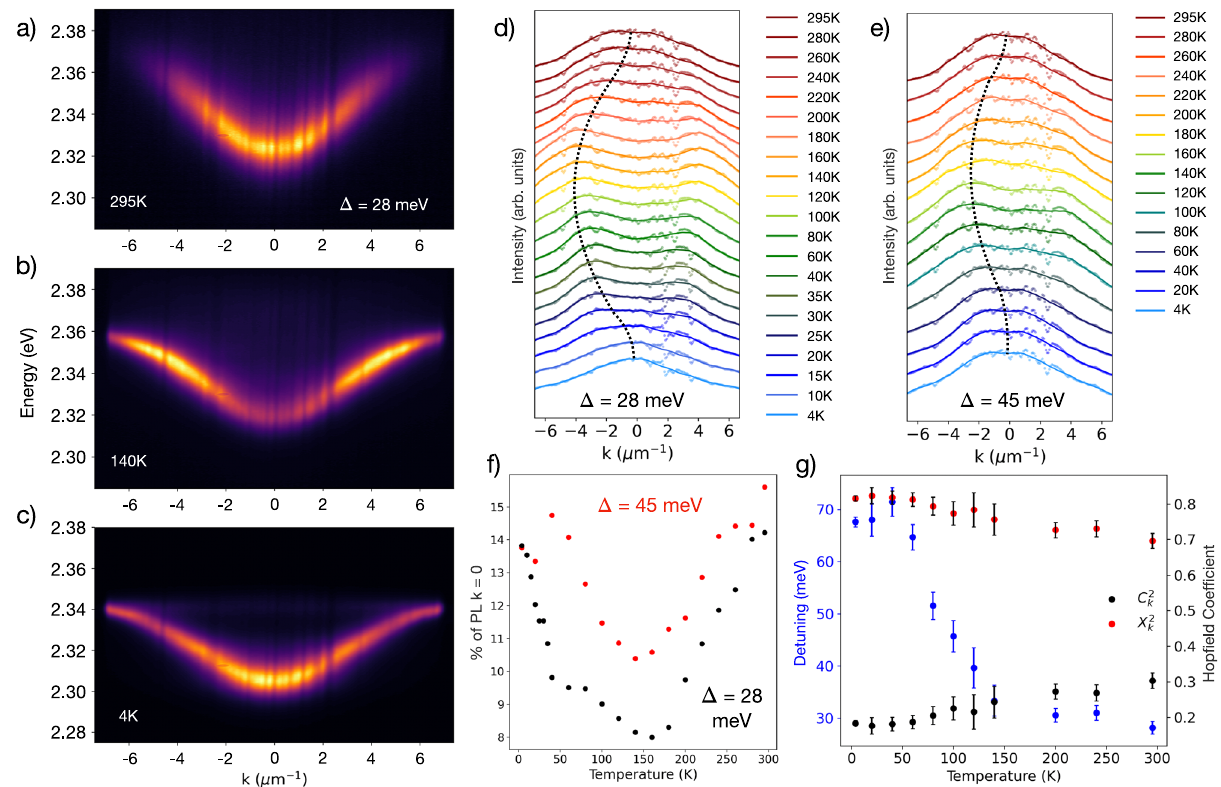
Fig. 2 | Temperature dependence of the exciton-polariton bottleneck effect. a – c Lower polariton branch (LPB) photoluminescence (PL) for Δ =+28meV cavity detuningasafunctionoftemperaturerevealing d , e theshiftingofthemaximumPL intensitytohigher k || atintermediatetemperaturesbeforereturningto k || =0at4K. d – f The temperature-dependence of the energy-integrated PL was monitored for twodetuningsestablishedatroomtemperature( _ Ω Rabi =175meV, Δ =+28meVand +45meV), with both detunings showing bottlenecked PL at intermediate